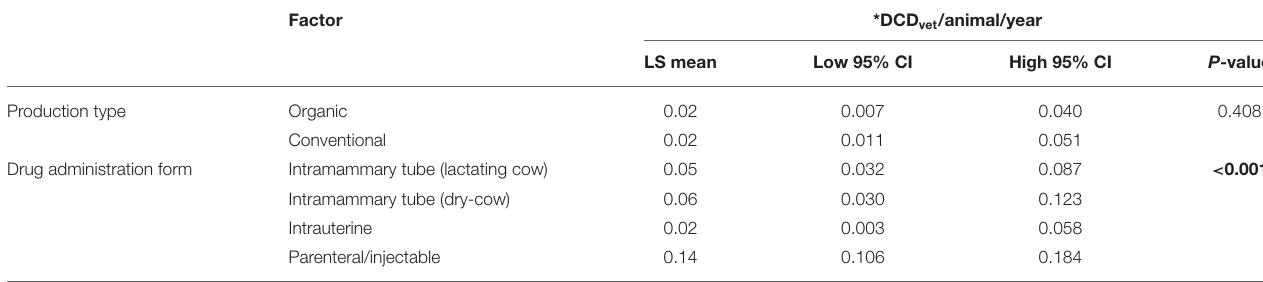
TABLE 3 | Associations between production type and drug administration form [least-square (LS) means, 95% confidence intervals (CI)] on antimicrobial use (obtained from VXA data) measured as the number of defined courses animal/year (DCD vet /animal/year) and as estimated in a linear mixed model, in a sample of 56 (27 Organic and 29 Conventional) Swedish dairy herds.